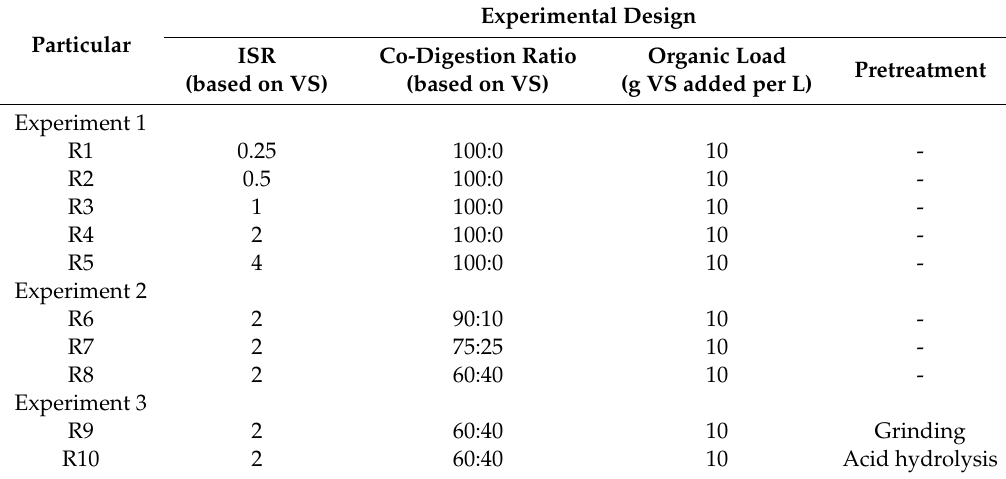
Table 1. Experimental conditions of the batch